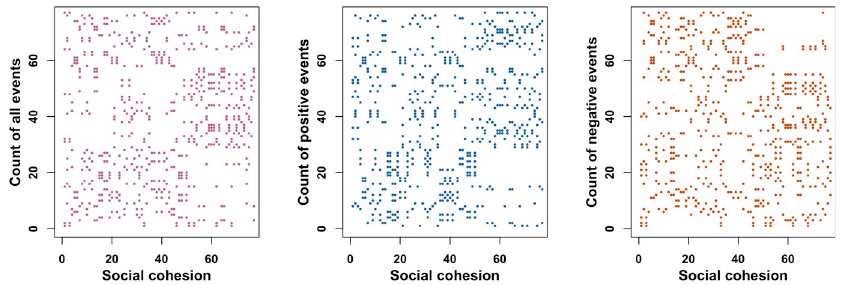
Fig 9. Recurrence plot (RP) for social cohesion and counts of events from source and target filtered